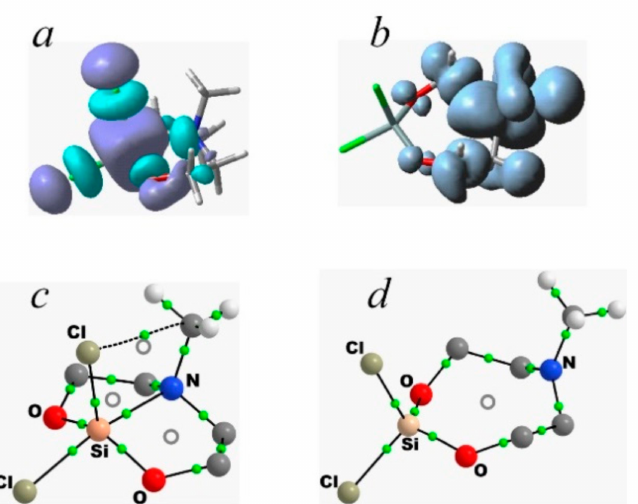
Figure 12. Doubly degenerated LUMO on two Si-Cl bonds of 7 ( a ) and mostly N-centered SOMO of 7 + • ( b ). Molecular graphs of 7 ( c ) and 7 + • ( d ) from AIM analysis; hollow circles—ring critical points rcp (3, +1), green circles—bond critical points bcp (3, − 1). For clarity, only the protons of the N-Me group are